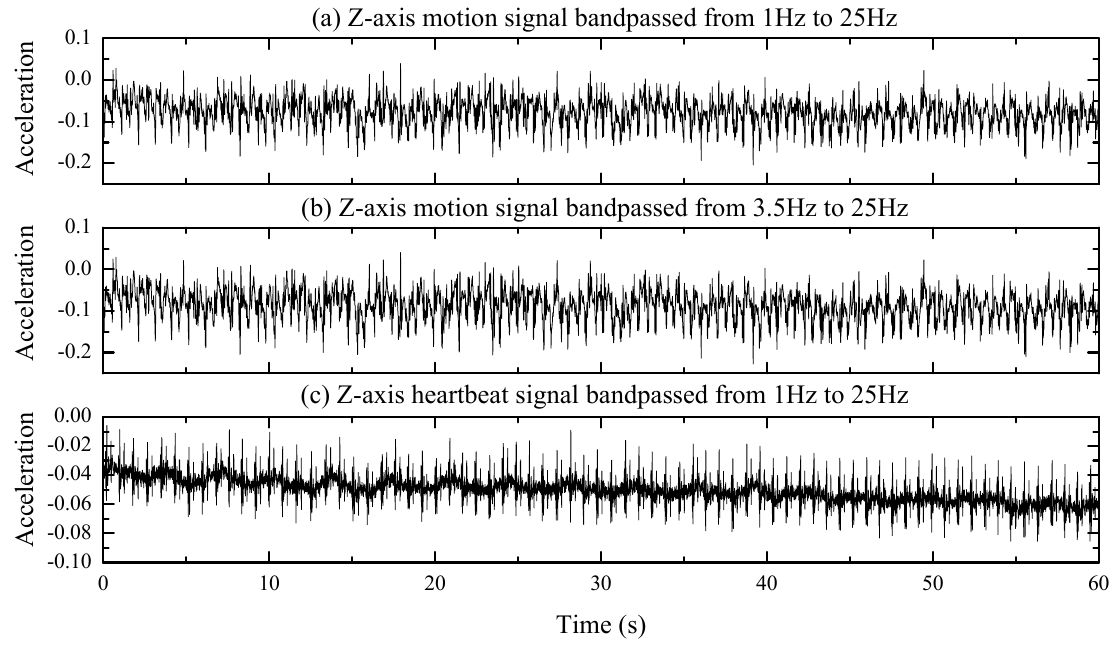
Figure 6. ( a ) Z -axis motion signal band passed from 1 to 25 Hz. ( b ) The Z -axis motion signal band Figure 6. ( a ) Z ‐ axis motion signal band passed from 1 to 25 Hz. ( b ) The Z ‐ axis motion signal band passed from 3.5 to 25 Hz. ( c ) The Z -axis heartbeat signal band passed from 1 to 25 passed from 3.5 to 25 Hz. ( c ) The Z ‐ axis heartbeat signal band passed from 1 to 25 Hz.